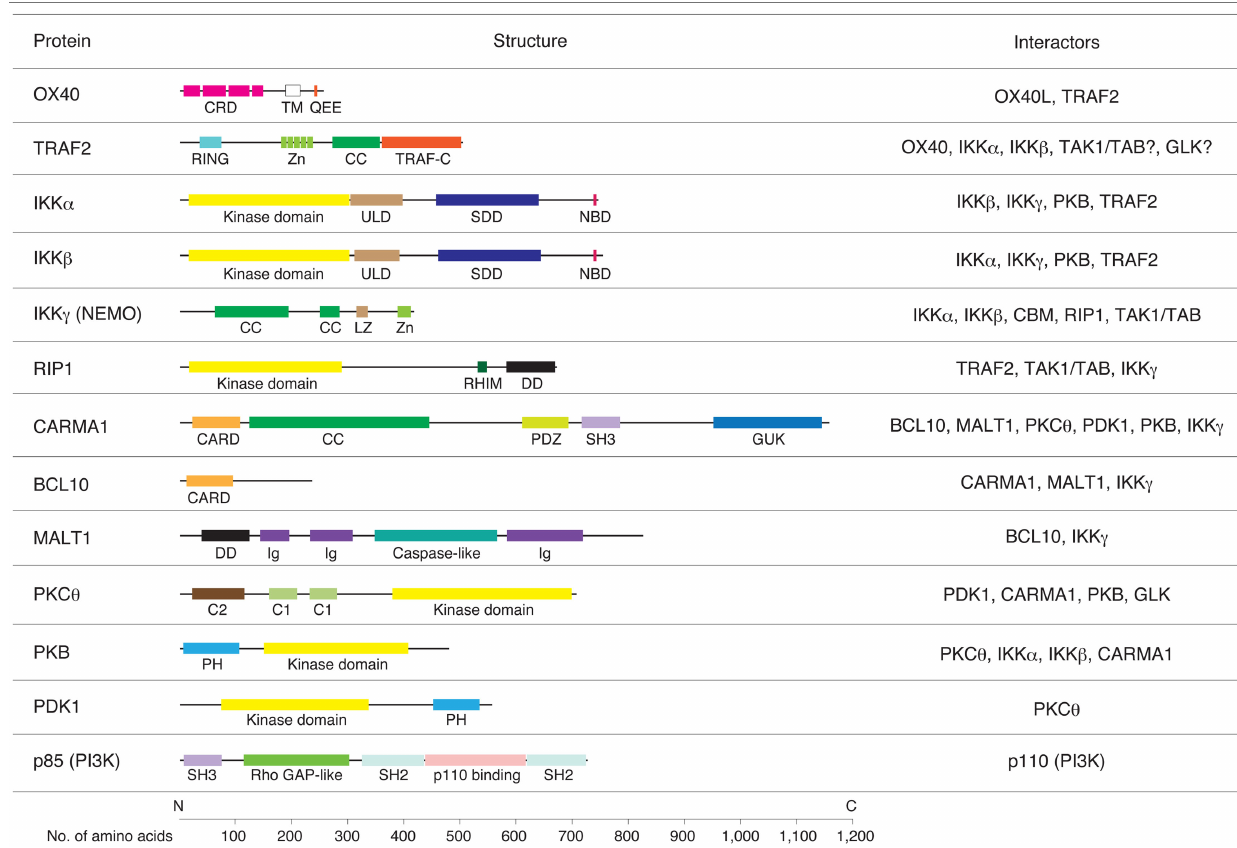
Table 1 | Proteins involved in the OX40 signalosome a,b